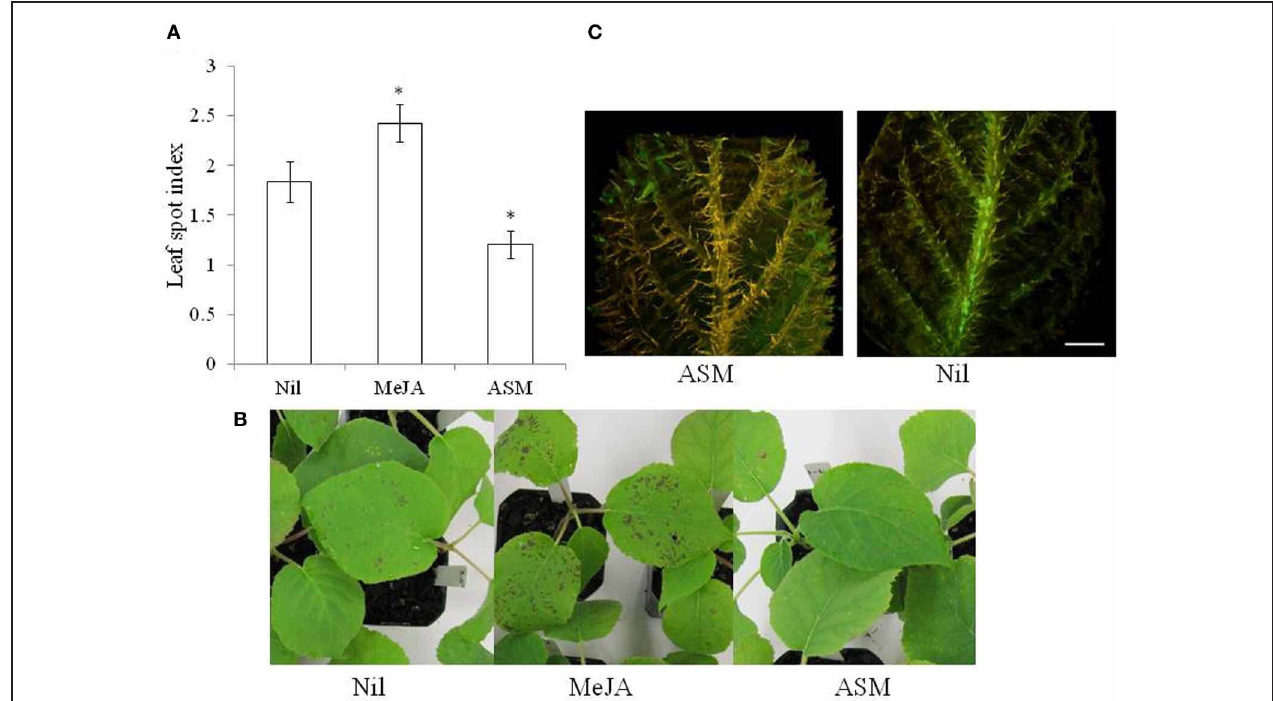
FIGURE 1 | (A,B) Effect of foliar spray with 1.7mM acibenzolar-S-methyl (ASM) and 1.1mM methyl jasmonate (MeJA) on Psa infection in Actinidia chinensis (A,B) . Treatments were applied 1 week before spray inoculation with a suspension containing 10 cfu ml